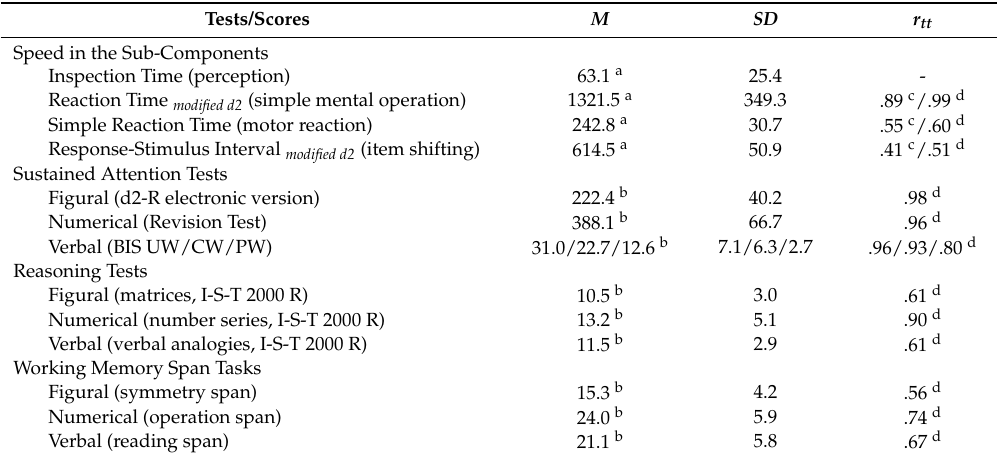
Table 1. Means, standard deviations, and reliability estimates of the measures in Study